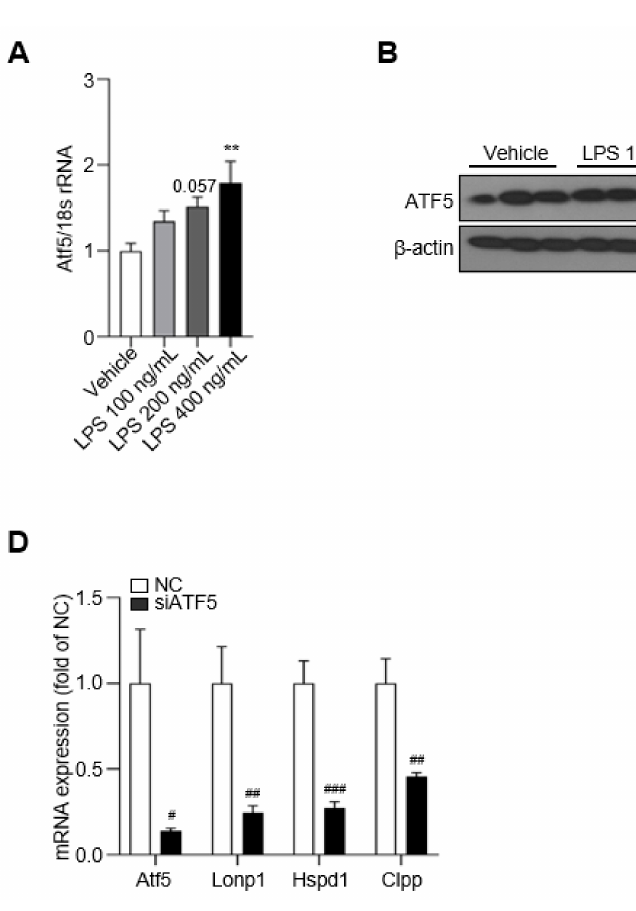
Figure 3. Treatment of LPS increases the level of ATF5, which can be silenced by siATF5. ( A ) The expression of Atf5 is upregulated in LPS-treated BV-2 cells at 48 h. ( B ) The protein level of ATF5 determined in LPS-treated BV-2 cells for 48 h. ( C ) The intensity value of ATF5 is shown. ( D ) The expression of Atf5 , Lonp1 , Hspd1 , and Clpp in NC- or siATF5-treated BV-2 cells for 24 h. Data are presented as mean ± SEM of three independent experiments (** p < 0.01, *** p < 0.001 compared to vehicle, # p < 0.05, ## p < 0.01, ### p < 0.001 compared to